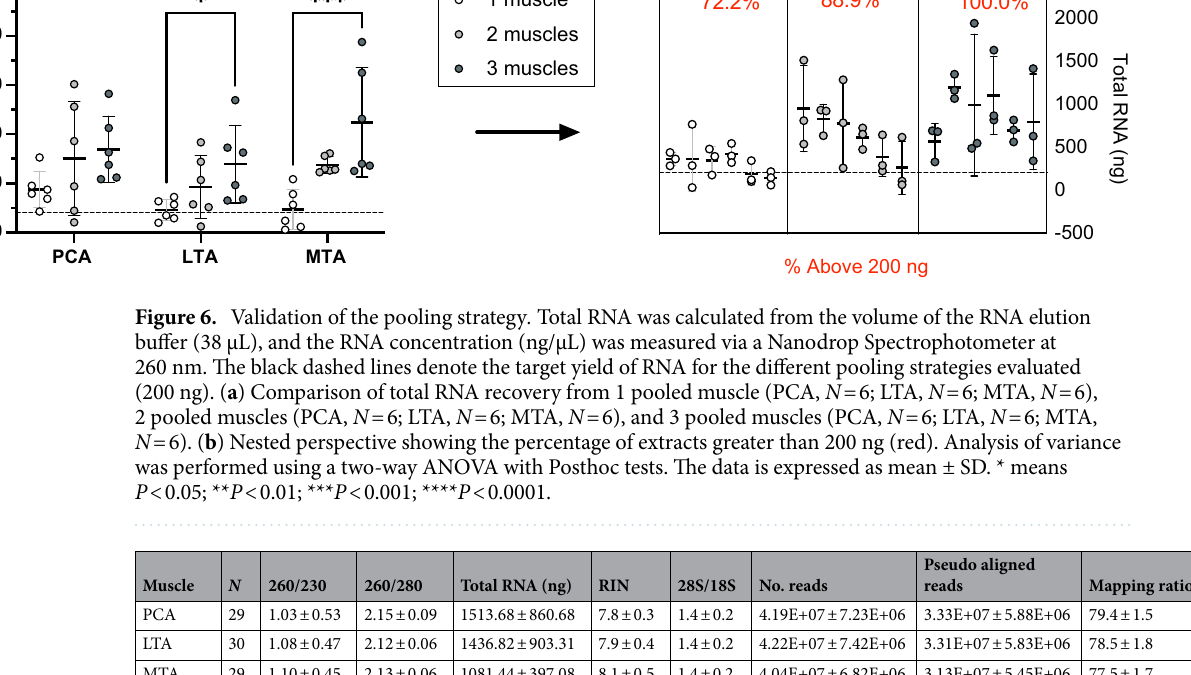
Table 4. Summary of the downstream diagnostics from experimental total RNA extracts ( N = 90). RNA samples were sequenced using a standard RNA-Seq pipeline (Illumina NovaSeq 6000), and sequencing reads were quantified using Kallisto. Note, the controls in this experiment were (1) RNA extracts from the right ILMs aggregated and (2) RNA extracts from all paired ILMs combined.